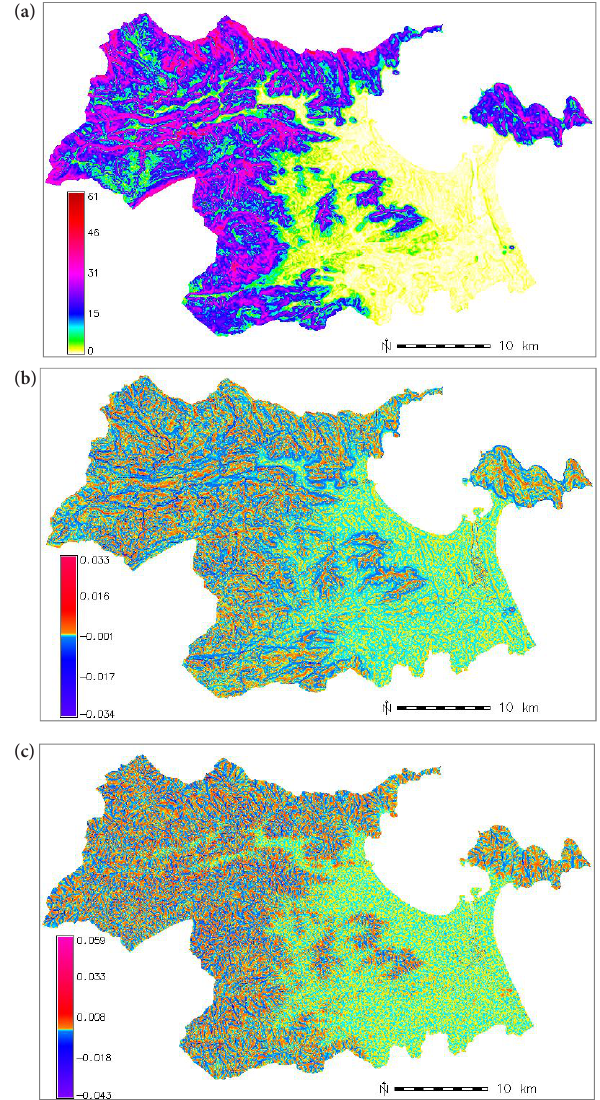
Figure 16. Slope (a) , profile curvature (b) and tangential curva- ture (c) maps extracted from the fused